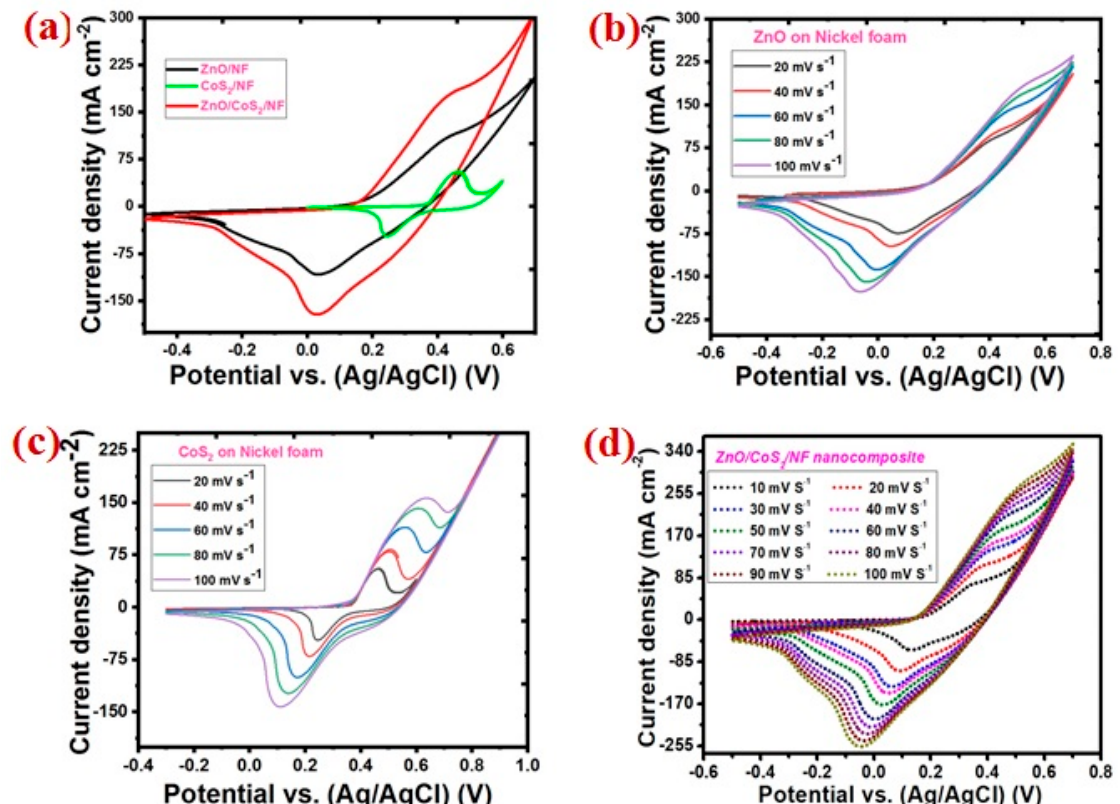
Figure 3. ( a ) CV curves of the ZnO, CoS 2 , and ZnO/CoS 2 /NF nanocomposite in 3 M KOH at a scan rate of 30 mV·s − 1 . CV curves of ( b ) ZnO, ( c ) CoS 2 , and ( d ) ZnO/CoS 2 /NF nanocomposites at various scan rates (20, 40, 60, 80, and 100 mV·s − 1 ).